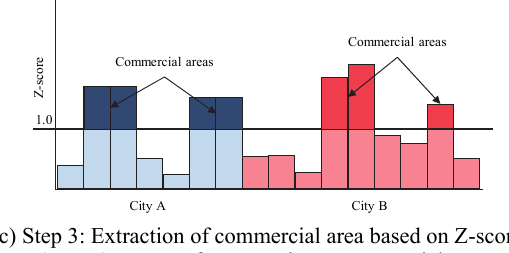
(b) Step 2: Aggregation of density to grid level